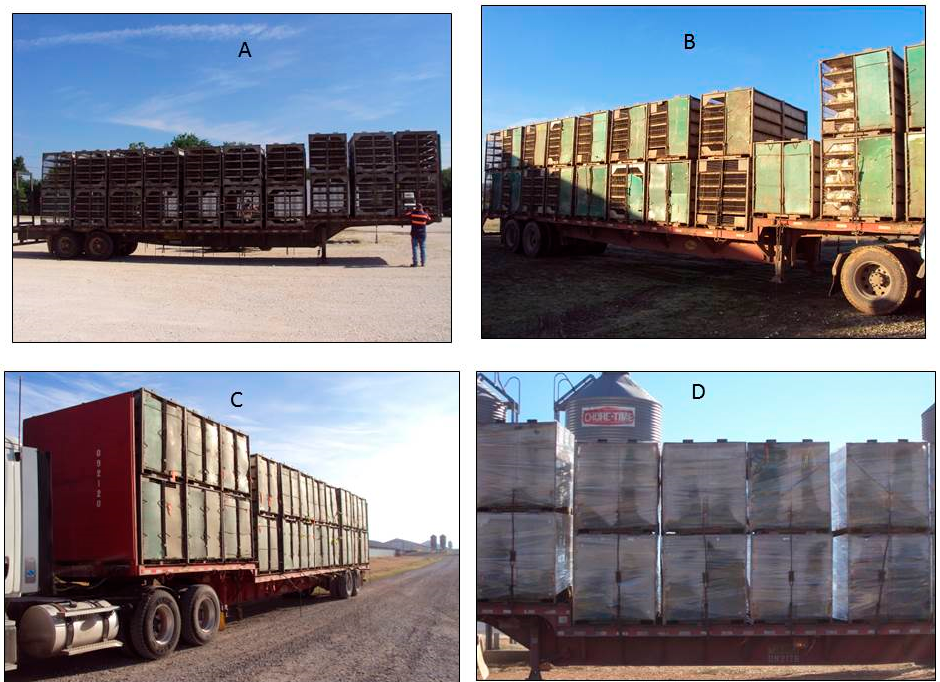
Figure 2. Weather-dependent trailer configurations employed by companies. A . Open, used for hot and mild seasons; B. Single board, used when transitioning between mild and winter seasons; C . Double board used in winter seasons; D . Plastic wrap on double board modules, used in winter days or nights with extremely cold conditions.